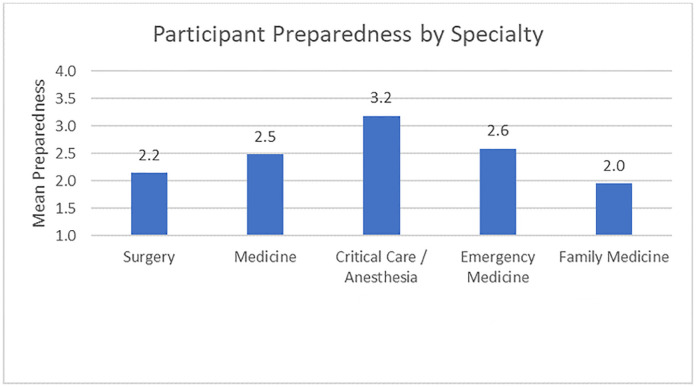
Physician preparedness by specialty.Self-reported physician preparedness to make resource allocation decisions by specialty, measured on a 4-point scale from 1 (not at all prepared) to 4 (very prepared). Note. Responses were measured on a 4-point Likert-type scale ranging from 1, not at all prepared, to 4, very prepared.